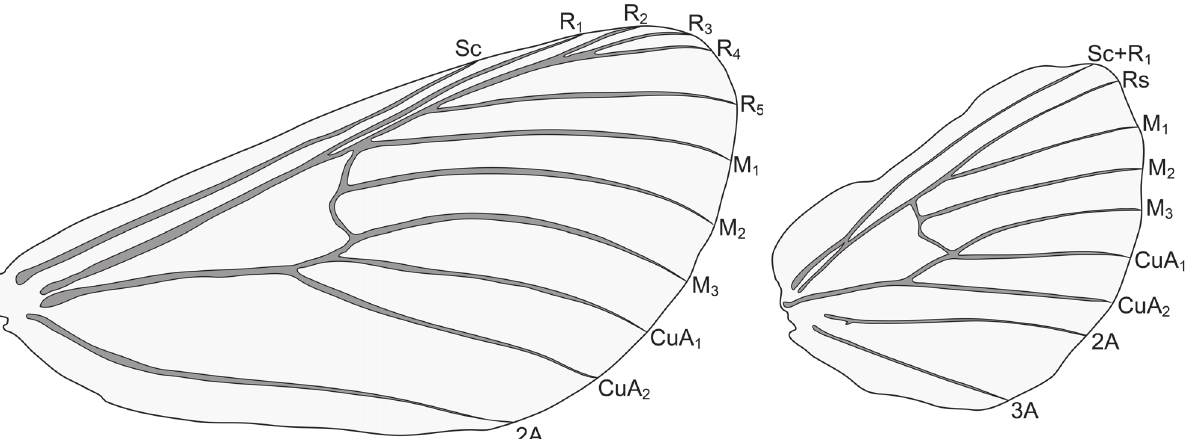
Figure 22. Fore and hind wings of L. dentilinea . (A) Anal vein, (CuA) cubital vein, (M) medial vein, (R) radial vein, (Rs) radial sector, (Sc) subcostal vein. Scale bar: